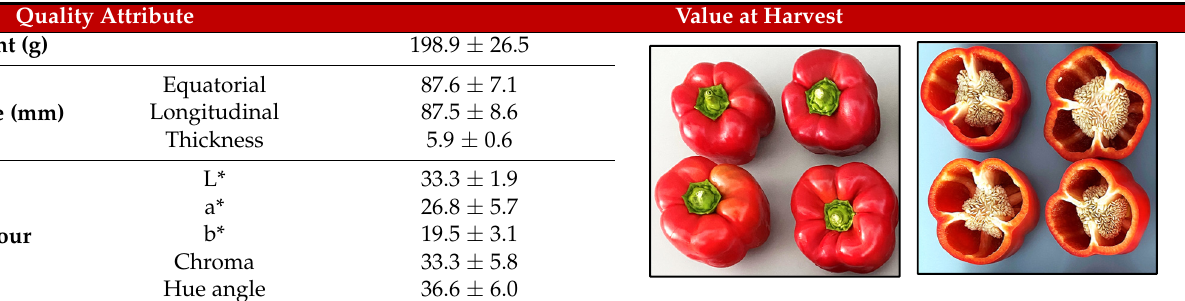
Table 1. Main quality parameters at harvest of studied bell peppers ( n = 25).